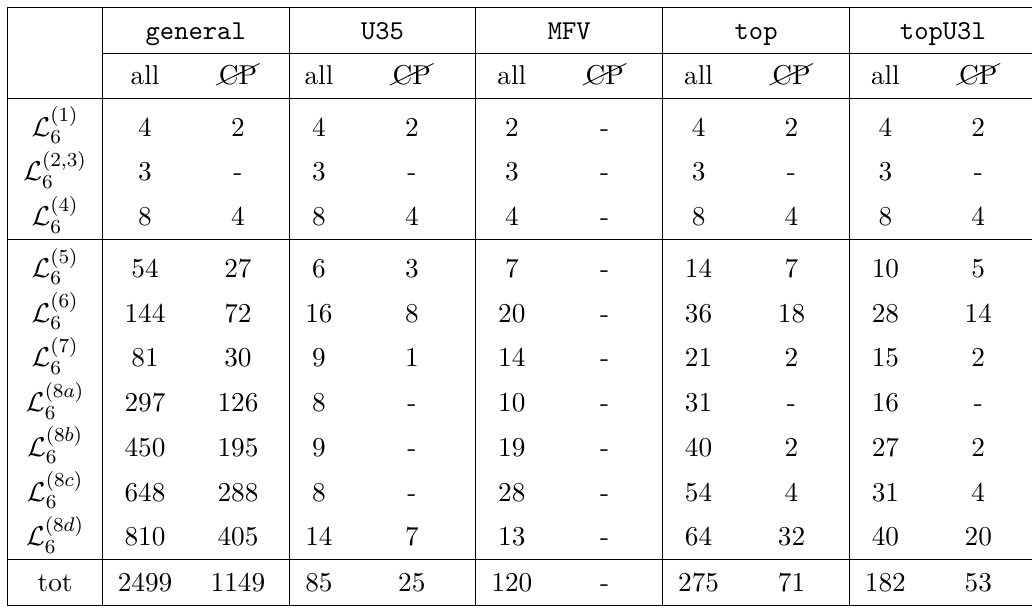
Table 3 . Number of independent real parameters in each class of dimension 6 operators, for the 5 flavor structures implemented in SMEFTsim